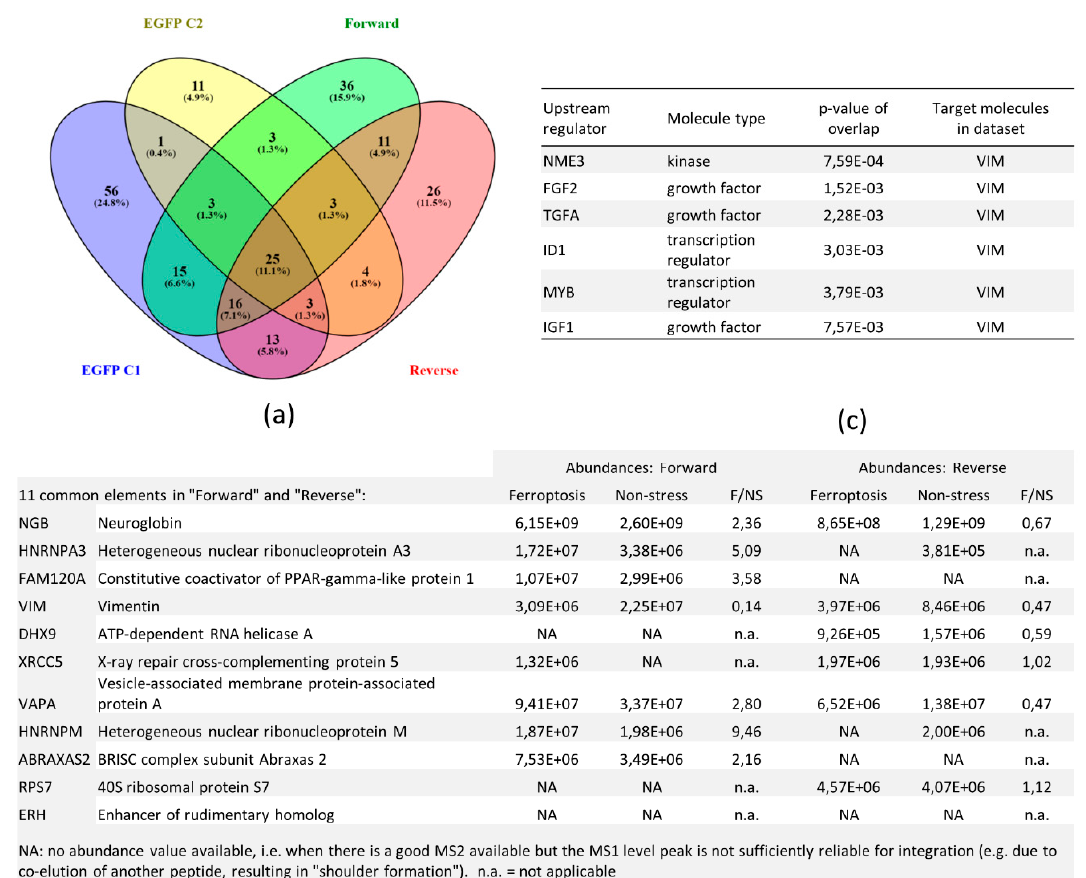
Figure 8. hNgb protein interactors in a ferroptotic condition. ( a ) Venn diagram of the different samples. The forward and reverse samples contain differently labeled proteins of the hNgb ‐ EGFP cells being unstressed or stressed with 50 μ M erastin for 24 h. Stable isotope labeling with amino acid in cell cultures (SILAC) labeling was coupled to a Co ‐ IP MS/MS analysis for protein identification. Proteins detected in the EGFP control samples 1 and/or 2 were considered to be background binders and were not included in further analyses. The Venn diagram was created with Venny 2.1 (http://bioinfogp.cnb.csic.es/tools/venny/). ( b ) Abundance values of the ten proteins, which were identified in both the forward and reverse run. Values are represented per condition, and ratios are taken thereof. ( c ) The top predicted upstream regulators of the signaling cascades, which are linked to the 10 identified hNgb ‐ binders.